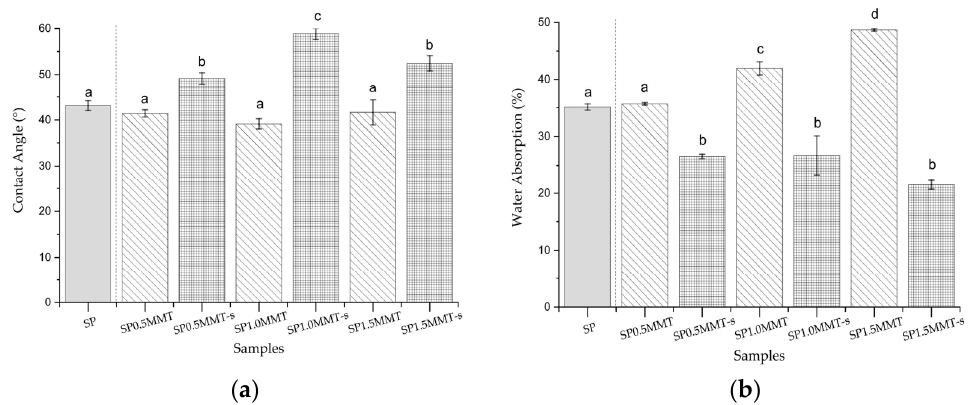
Figure 8. Effect of MMT nanoclay concentration and ultrasound treatment on ( a ) contact angle and ( b ) water absorption of starch/PVA (SP) composite films. SP control sample without nanoclay. Different letters (a, b, c, d) in the same column denote significant differences for the set of means in each treatment (with and without ultrasound) ( p < 0.05).